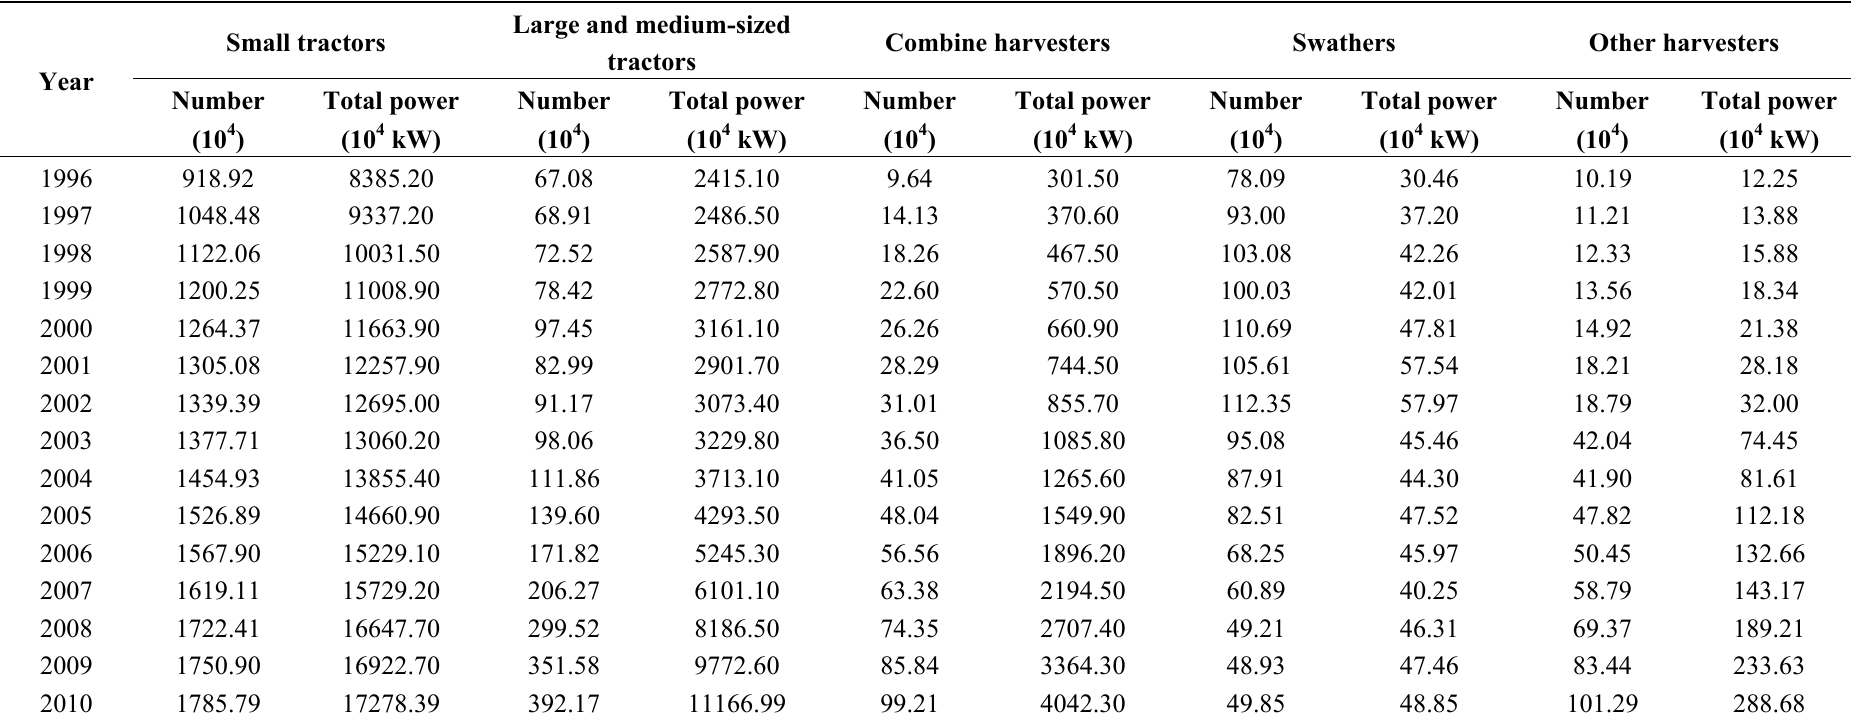
Table A2. Number and total power of agricultural